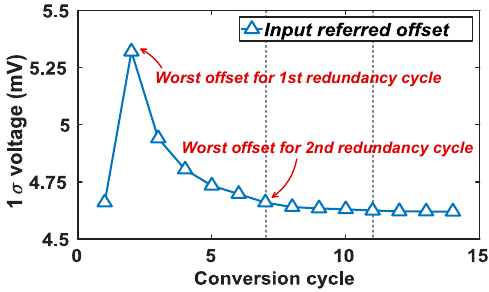
Figure 10. The block diagram of the SAR ADC with the proposed SCRD.